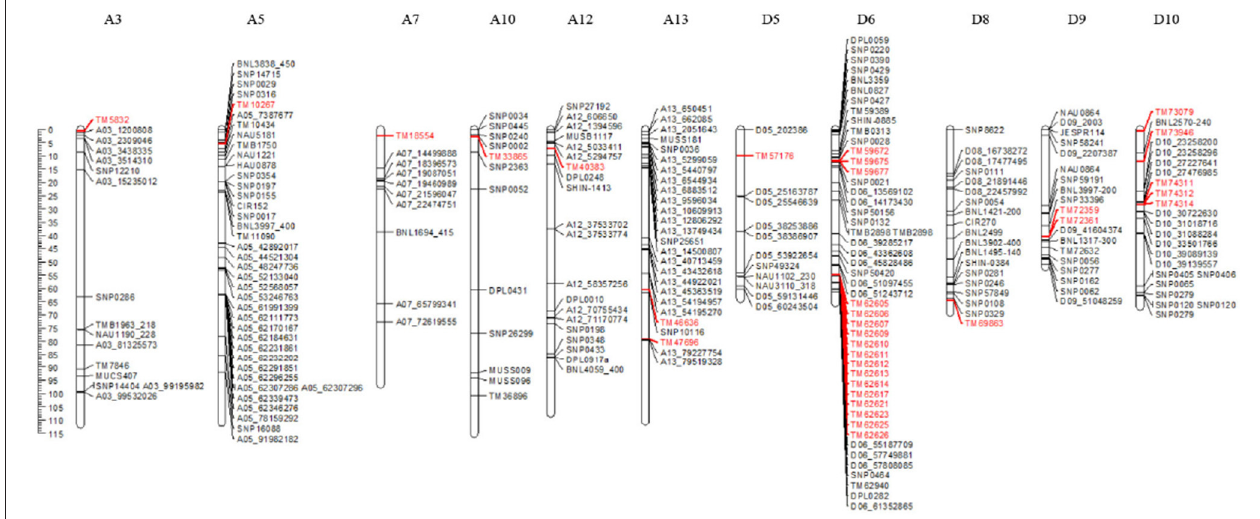
FIGURE 4 | Meta-analysis of markers related to drought-tolerance traits. The markers shown in red represent the SNPs detected in this study.